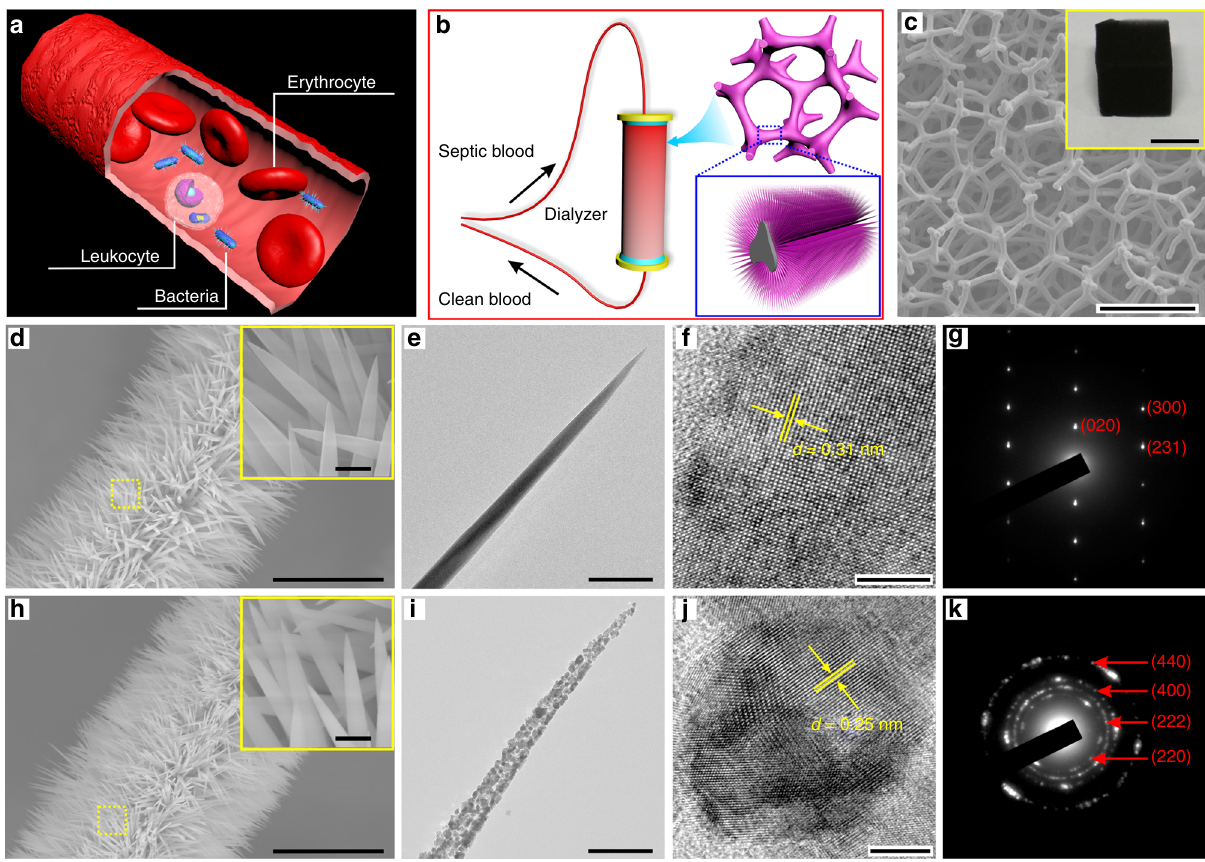
Fig. 1 Fabrication and characterization of a dialyzer. a Schematic illustration of the complex blood environment in a blood vessel demonstrating the challenge of bacterial capture. b Blood cleansing by fl owing the bacteria-contaminated blood through a dialyzer. c SEM image showing the internal structure of a dialyzer composed of NWs pre-grown on CF, and a photo of whole NWs/CF shown in the inset. Scale bars in c and inset are 250 μ m and 1 cm, respectively. d – g Structural characterization of single-crystalline NWs. d Low- and high-magni fi cation (inset) SEM images. e TEM image showing the NW has only one crystal domain. f HRTEM image and g responding SAED pattern demonstrate single crystal feature. h – k Structural characterization of polycrystalline NWs. h Low- and high-magni fi cation (inset) SEM images. i TEM image of an individual NiCo 2 O 4 NW showing multi-grain boundaries. j HRTEM image and k responding SAED pattern con fi rm the multi-crystal zones. Scale bars in d and h are 10 μ m. Scale bars in the insets of d and h are 500 nm. Scale bars in e and i are 200 nm. Scale bars in f and j are 5